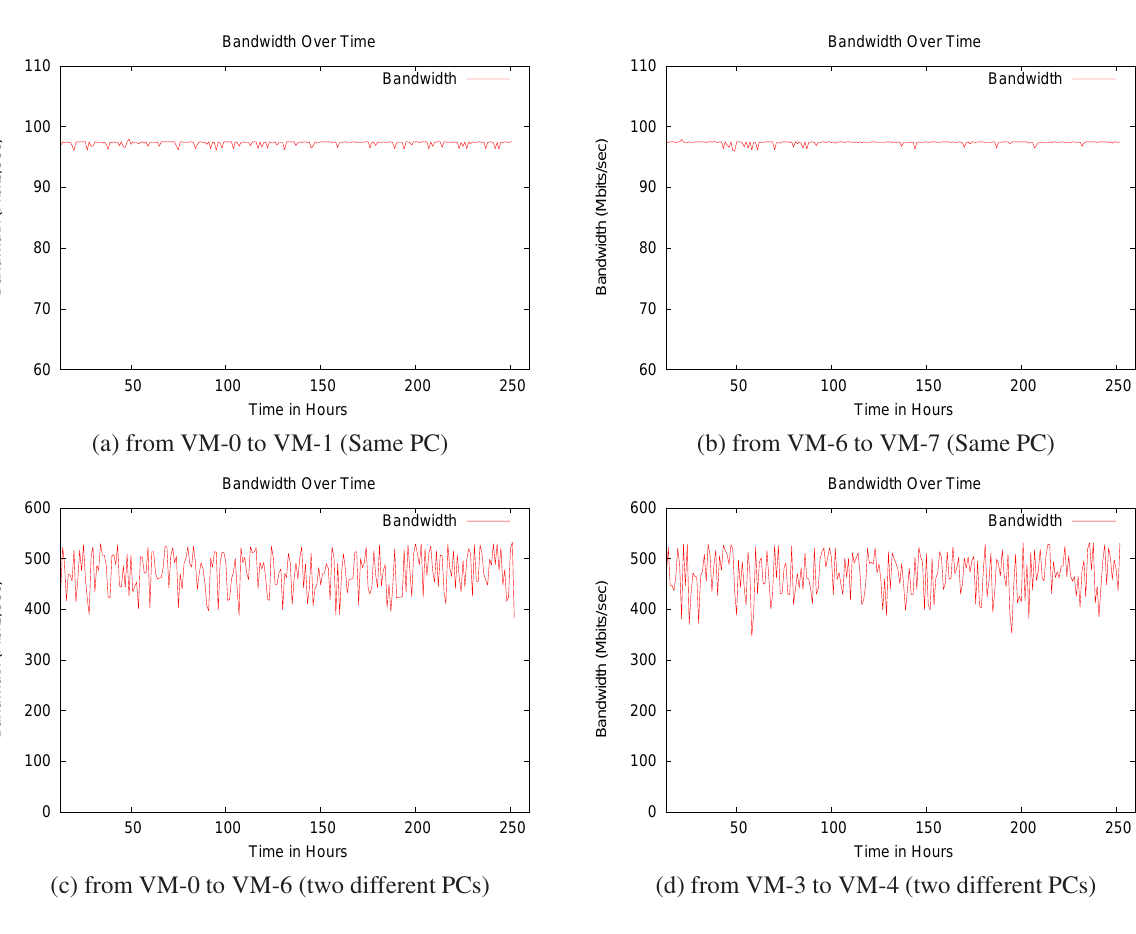
Figure 7. Bandwidth of the links connecting two VMs from the same Aggregate